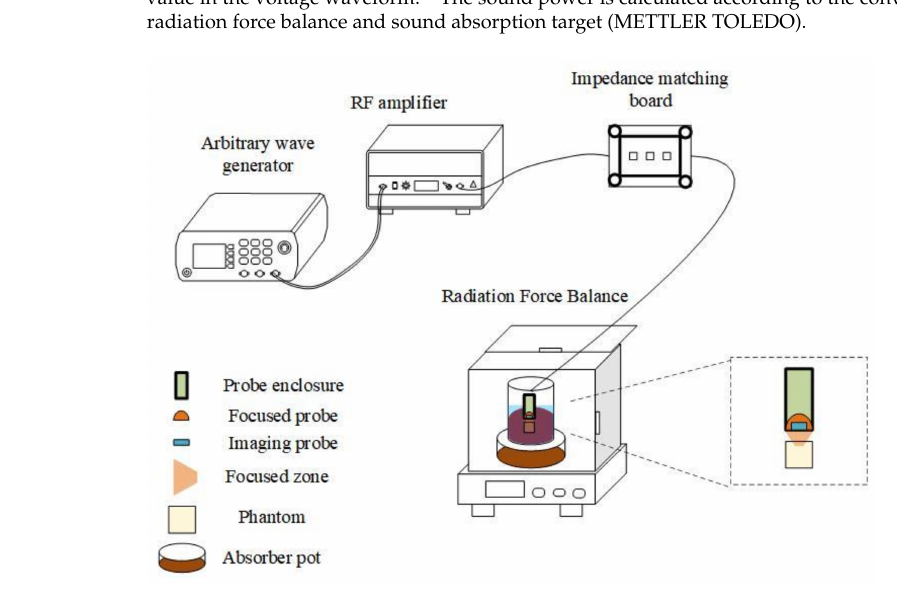
Figure 5. Sound power measurement